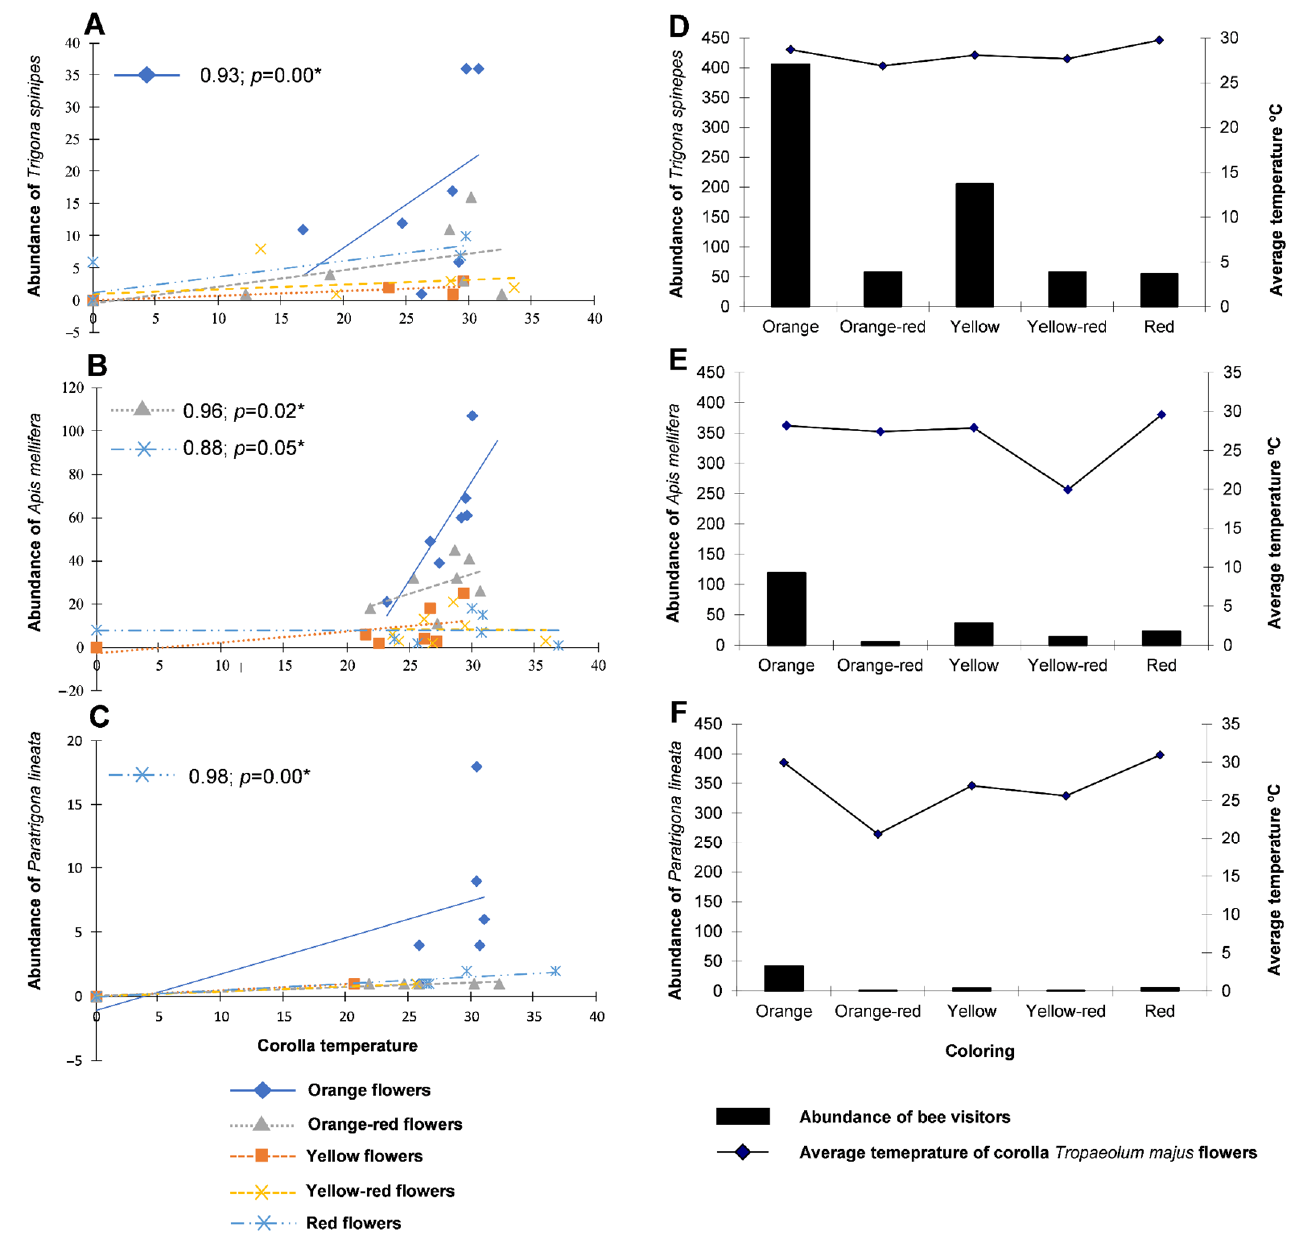
Figure 3. Dispersion corresponding to Spearman’s coefficient correlations between the temperature of the Tropaeolum majus corolla and the abundance of Trigona spinipes ( A ), Apis mellifera ( B ), Paratrigona lineata ( C ), and the abundance of Trigona spinipes ( D ), Apis mellifera ( E ), and Paratrigona lineata ( F ) and the average temperature of the corollas of different colors of Tropaeolum majus flowers. * Statistical significance of spearman correlation, p -value ≤ 0.05